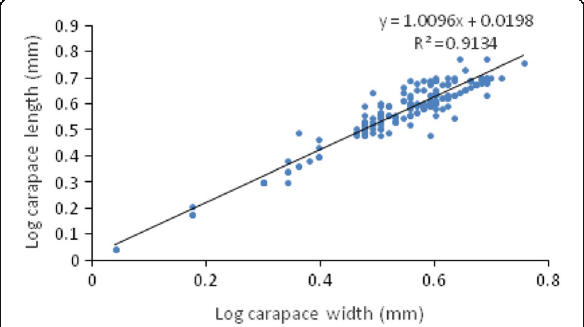
Fig. 3 Carapace width and carapace length relationship of H. marsupialis from Gulf of Aqaba, Red Sea,